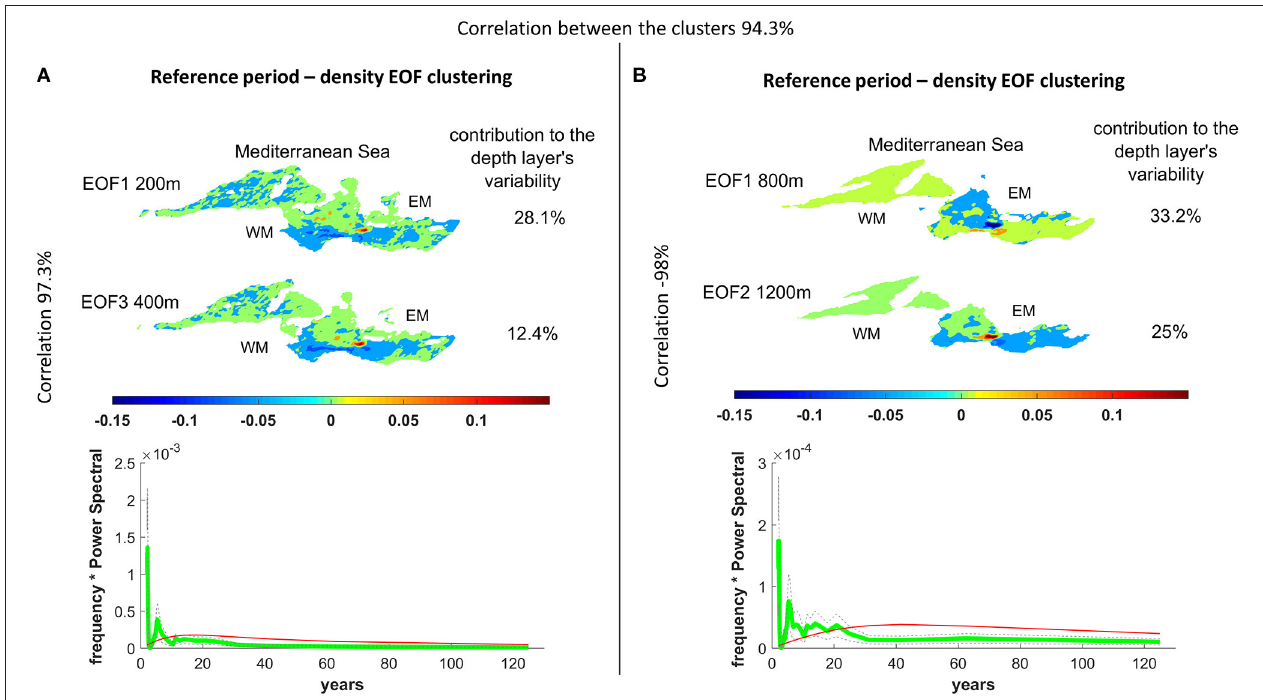
FIGURE 10 | As in Figure 9 , for the two clusters of (A) intermediate (first EOF of 200m and third EOF of 400m depth) and (B) deeper layers (first EOF of 800m and second EOF of 1,200m) with a 2-year cycle of variability as shown from the variance-preserving spectrum of the EOF modes of 400 (A) and 1,200m (B) , respectively.